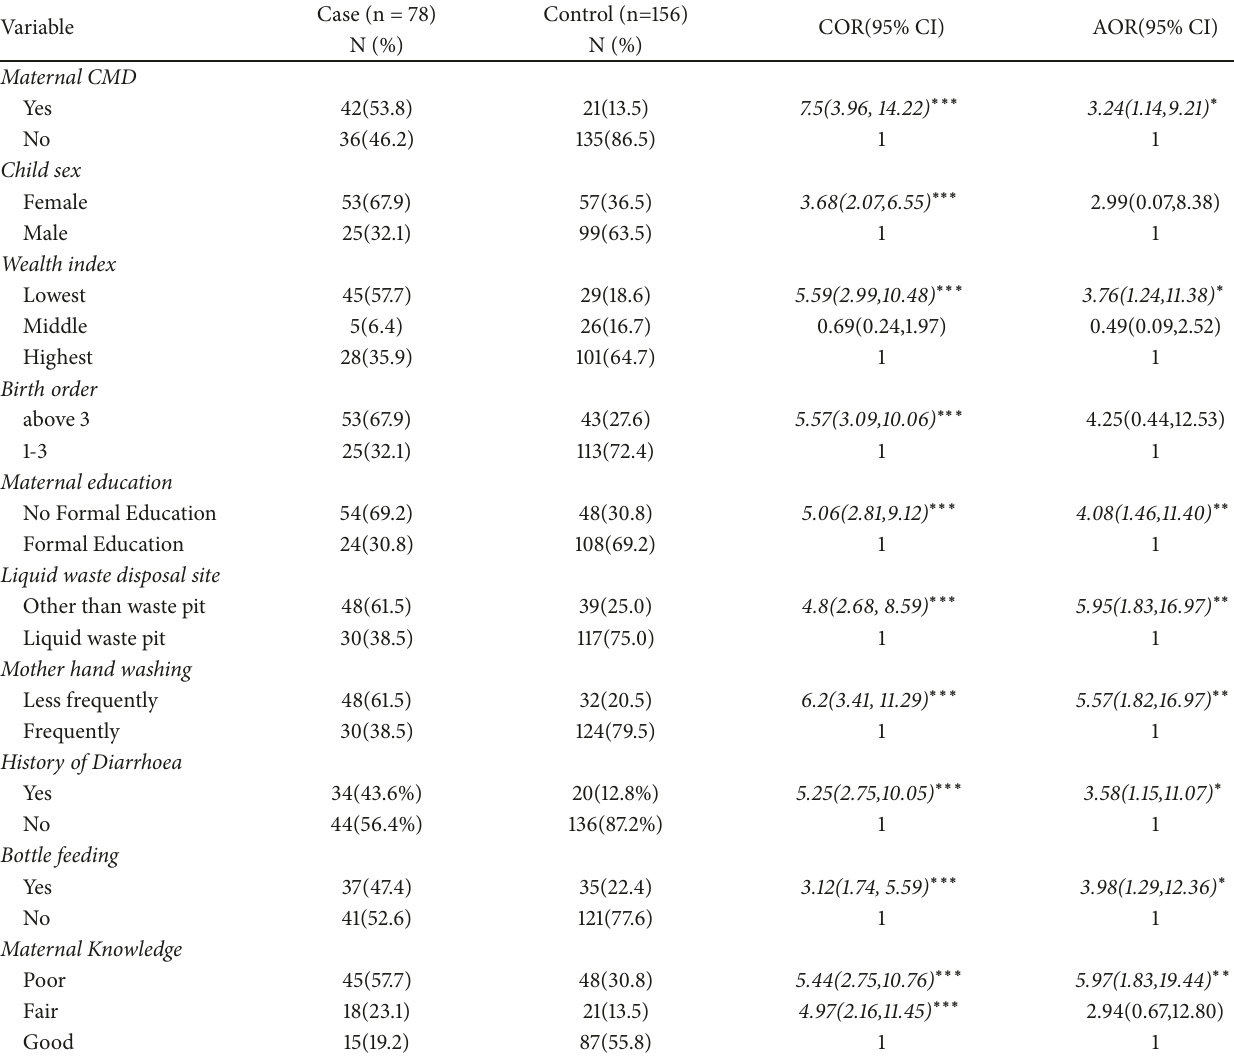
Table 3: Independent predictors of stunting of study participants of Nekemte town, West Ethiopia,